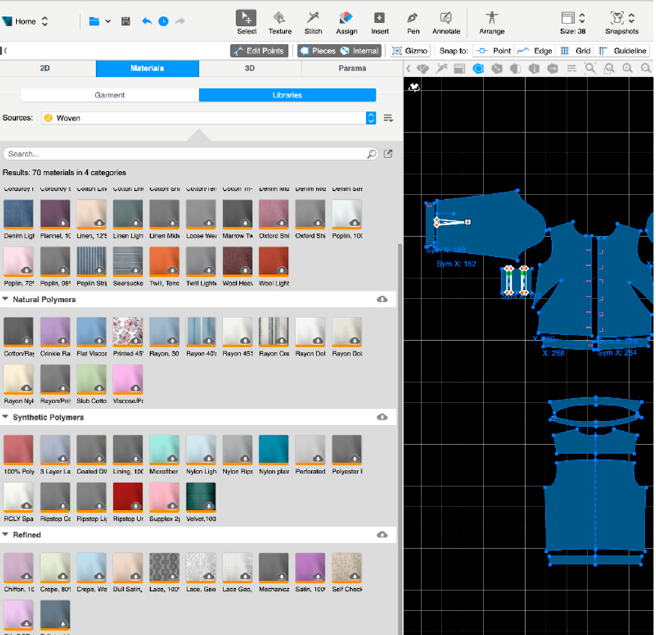
Figure 11. Fabric selection library, expandable by the user according to antenna design needs.